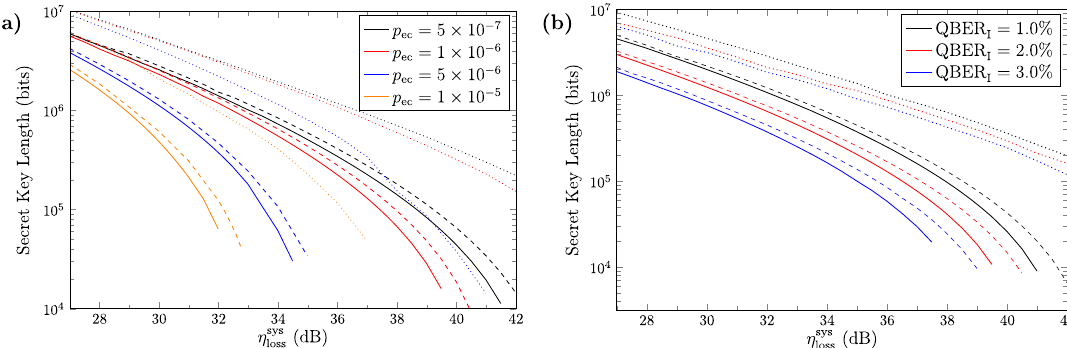
Fig. 3 SKL with system loss metric. Fixed system parameters were p ap = 10 − 3 , θ min ¼ 10 (cid:2) . In both plots, solid lines represent the optimised SKL with a single zenith overpass, dashed lines represent the two-pass normalised SKL, and dotted lines represent the normalised block